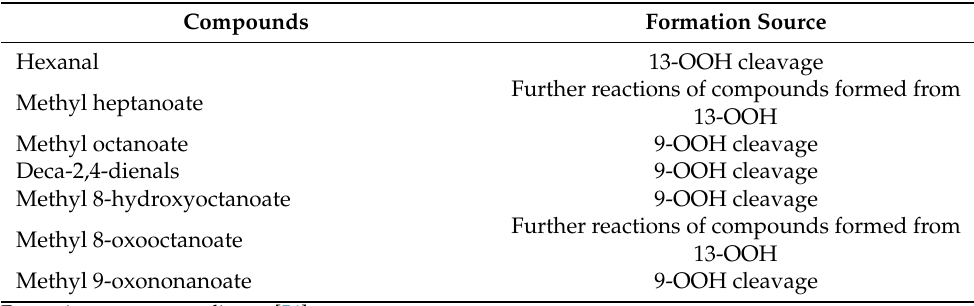
Table 3. Major volatiles found by GC-MS after simulated gastric digestion of methyl linoleate hydroperoxides (9-OOH and